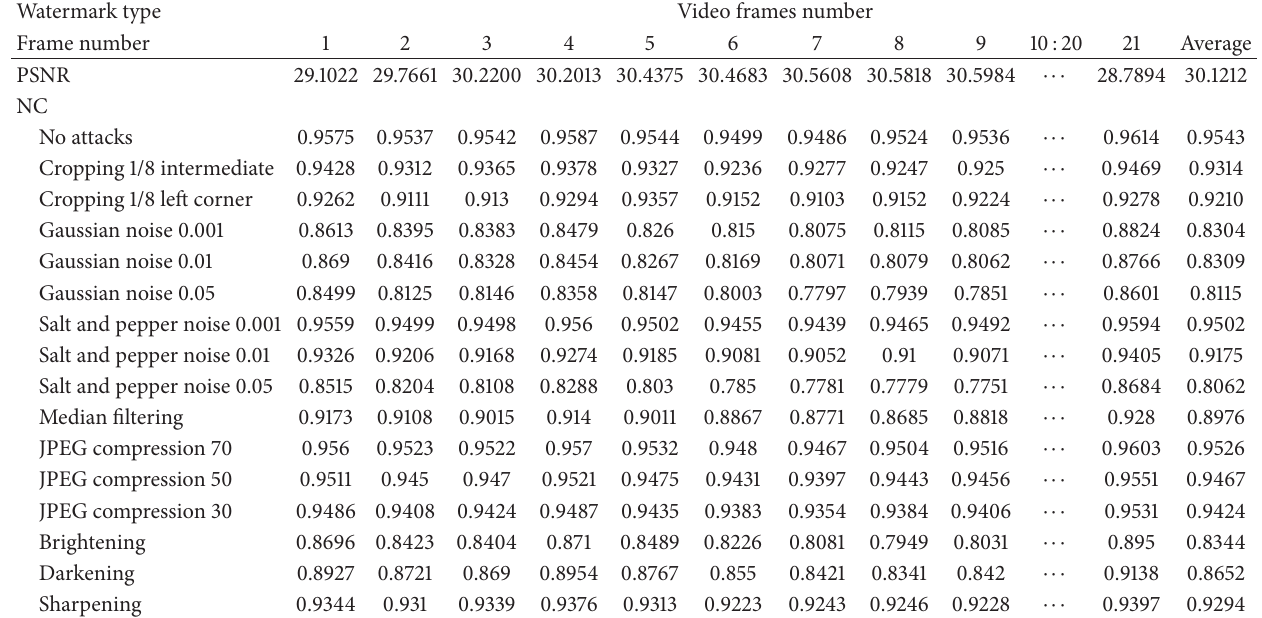
Table 3: Video Watermark (without interlacing) for all video